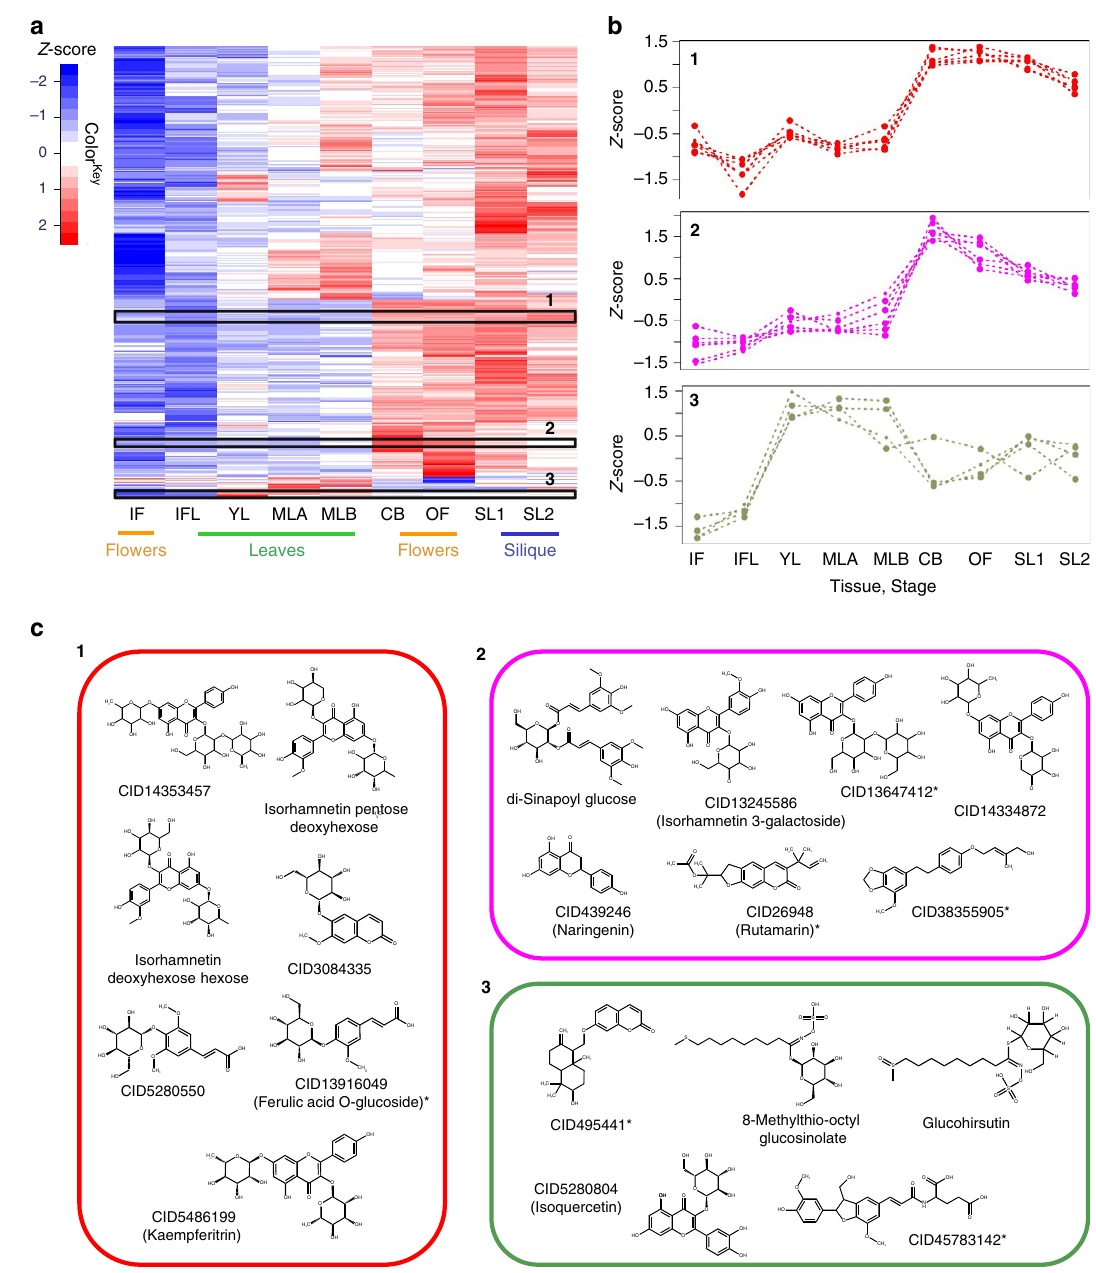
Figure 6 | Grouping of new and previously reported metabolites in the model species A. thaliana . ( a ) The heat map presents the relative intensity profiles of LC–MS peak groups. The samples (denoted in columns) were clustered according to tissues and developmental stages: inflorescence (IF); inflorescence leaves (IFL); young leaves (YL); mature leaves 3–4 and 7–8 weeks old (MLA and MLB respectively); closed buds (CB); open flowers (OF); and silique of 1 and 2cm length (SL1 and SL2, respectively). Peak groups (denoted in rows) were clustered according to intensity profiles. Three metabolite clusters of interest are outlined in black. ( b ) The three metabolite clusters of interest are shown in detail. Metabolites are those reported for the first time in A. thaliana and ones previously assigned and reported in the species. ( c ) The chemical structures and PubChem CIDs corresponding with metabolite clusters in b are shown inside the colour boxes. See also ‘Clustering of chromatographic peaks by intensity profiles’ in the Methods